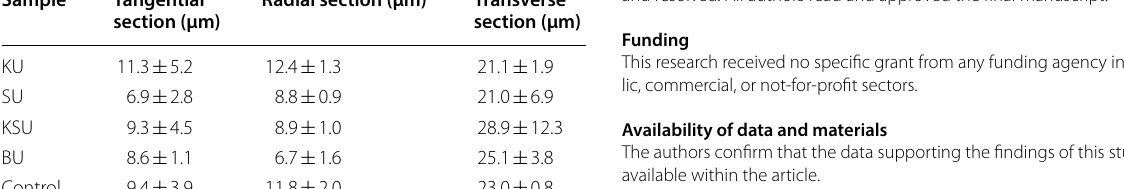
the other urushi. Increased hardness and smoothness of wood samples obtained by coating with urushi could be effective in preventing termite penetration.